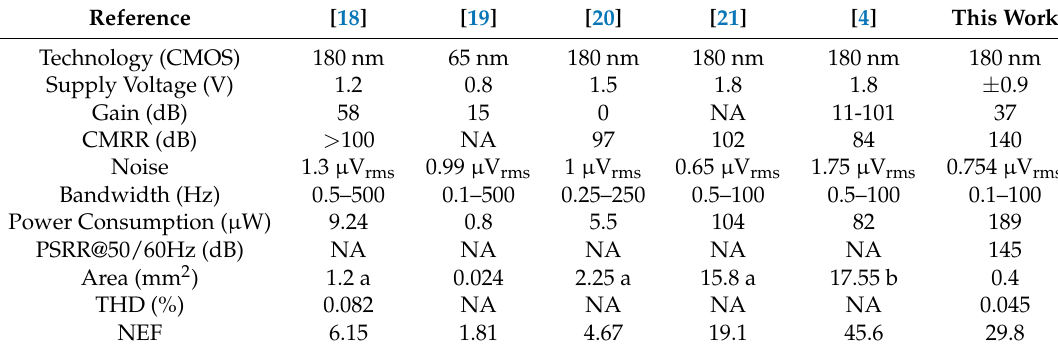
Figure 14. Measured open loop (R load = 10 M Ω and C load = 95 pF) input voltage range using an input sine wave at 100 Hz. Table 1. LPGA Performance Summary and